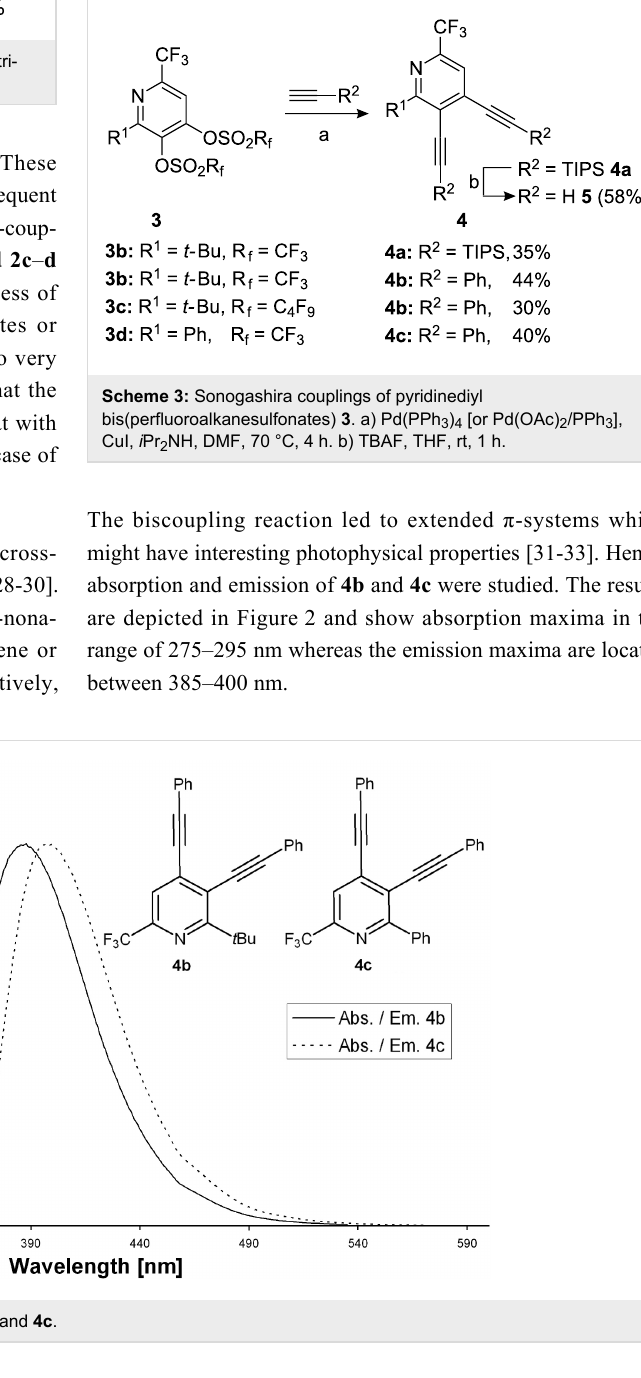
Scheme 2: Conversion of pyridine-3,4-diols 2 into pyridinediyl bistri- flates or -nonaflates 3 . a) Et 3 N, Rf 2 O, CH 2 Cl 2 , 0 °C to rt, 1 d.